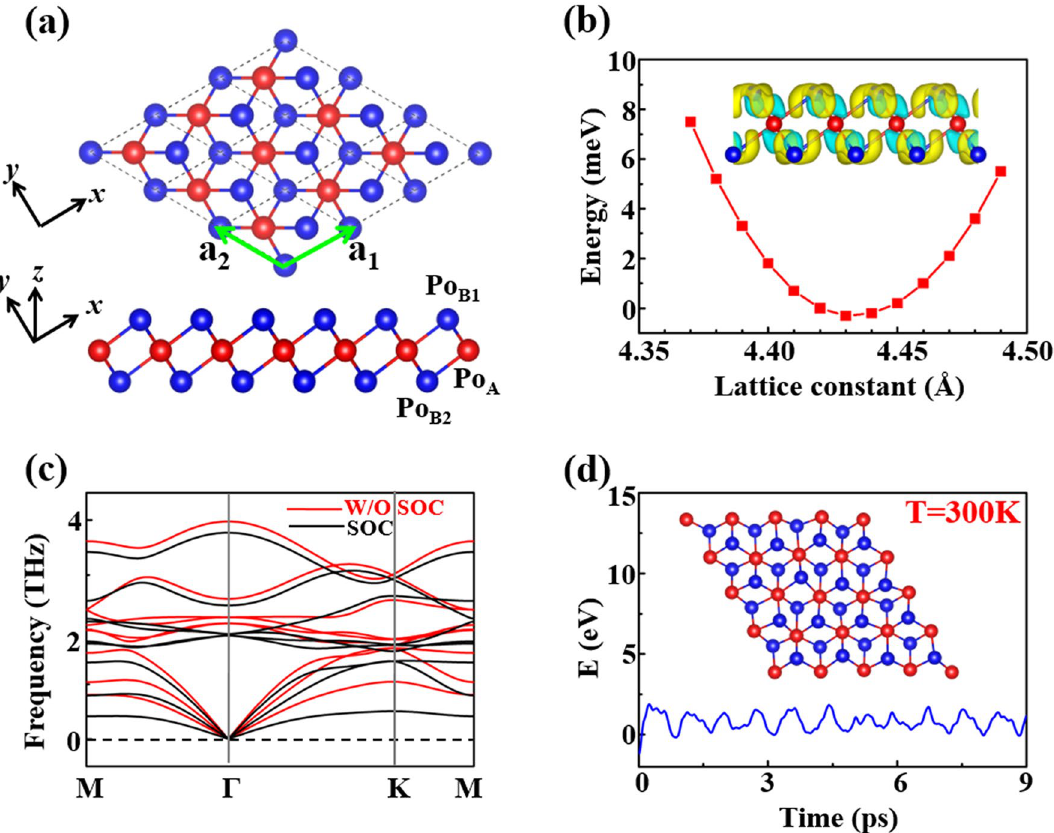
Figure 1. ( a ) Top and side views of the trigonal poloniumene. The red (blue) spheres denote the Po atoms at the central (outer) layer(s). ( b ) The total energy as a function of the lattice constant, where the total energy (− 8.918 eV) of the equilibrium structure with a 0 = 4.43 Ǻ is set as zero energy reference. The inset shows the difference of the charge densities between the poloniumene and the isolated Po atoms. The yellow color indicates gaining electrons, while the blue indicates losing electrons. ( c ) Phonon dispersion curves of the trigonal poloniumene without (red curves) and with (black curves) SOC. ( d ) Energy variation of the trigonal poloniumene during the AIMD simulations at 300 K, where the total energy (− 140 eV) is set as zero energy reference. The inset displays a snapshot of the final frame of the poloniumene at a time of 9